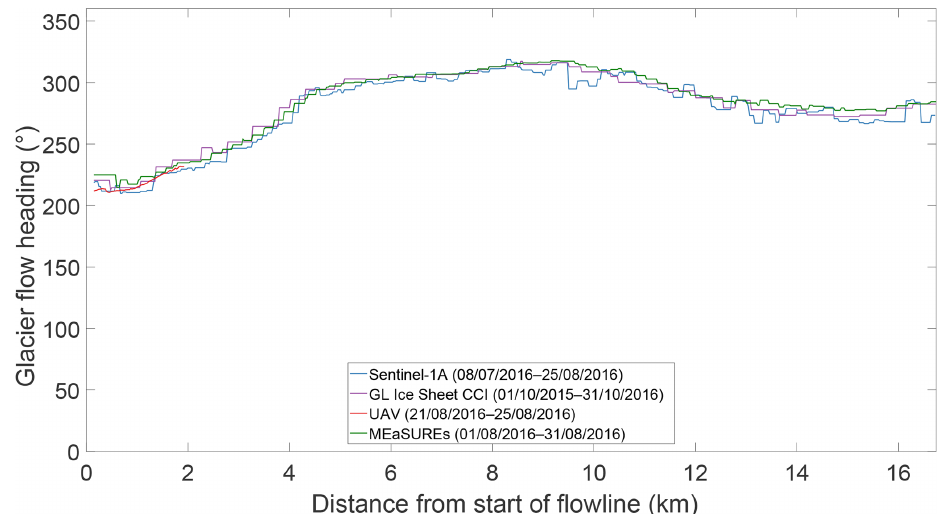
Figure A8. Mean flow direction in degrees referenced to north along the central flowline (see Fig. 1) derived from S1A scenes acquired between 8 July and 25 August 2016 (48d), starting at the glacier’s terminus. Reference flow heading based on the 4d UAV mosaics acquired on 21 and 25 August 2016 is shown in red, and the flow directions from MEaSUREs and Greenland Ice Sheet CCI products are shown in green and purple. Mean absolute differences along the flowline are 5.8 ◦ between our SAR-based results and the Greenland Ice Sheet CCI product, and are 6.1 ◦ when compared to the product from